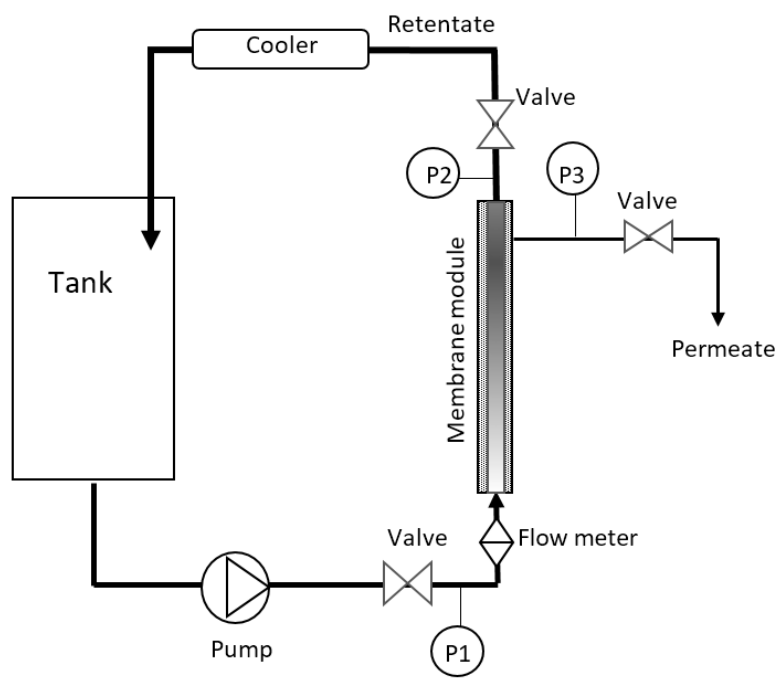
Figure 1. Schematic diagram of the ceramic membrane filtration system (P1, P2, P3-manometers).